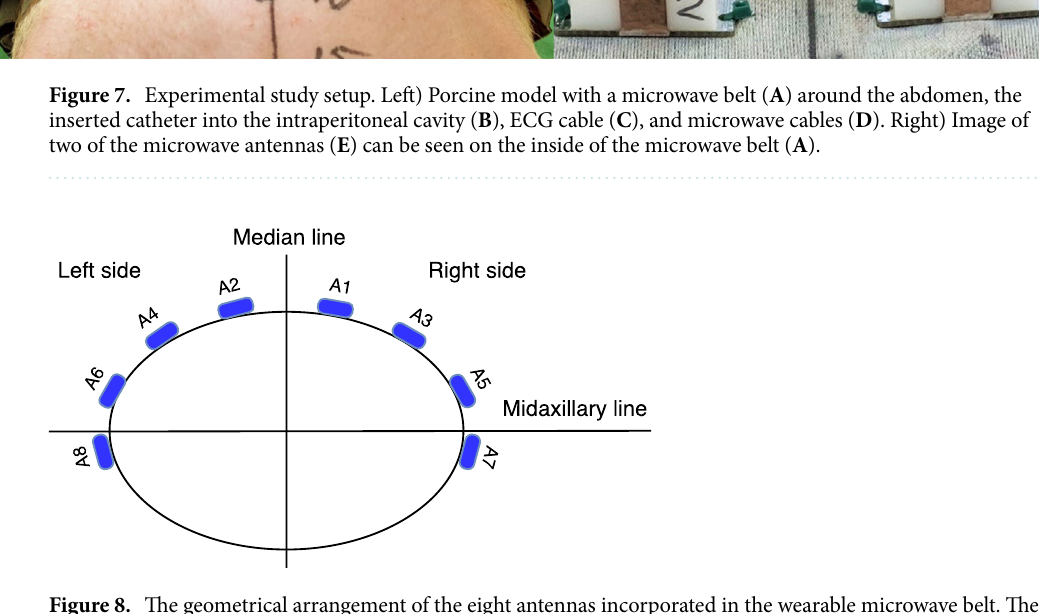
Figure 8. The geometrical arrangement of the eight antennas incorporated in the wearable microwave belt. The antennas were numbered so that even antennas were on the left side and odd antennas on the right